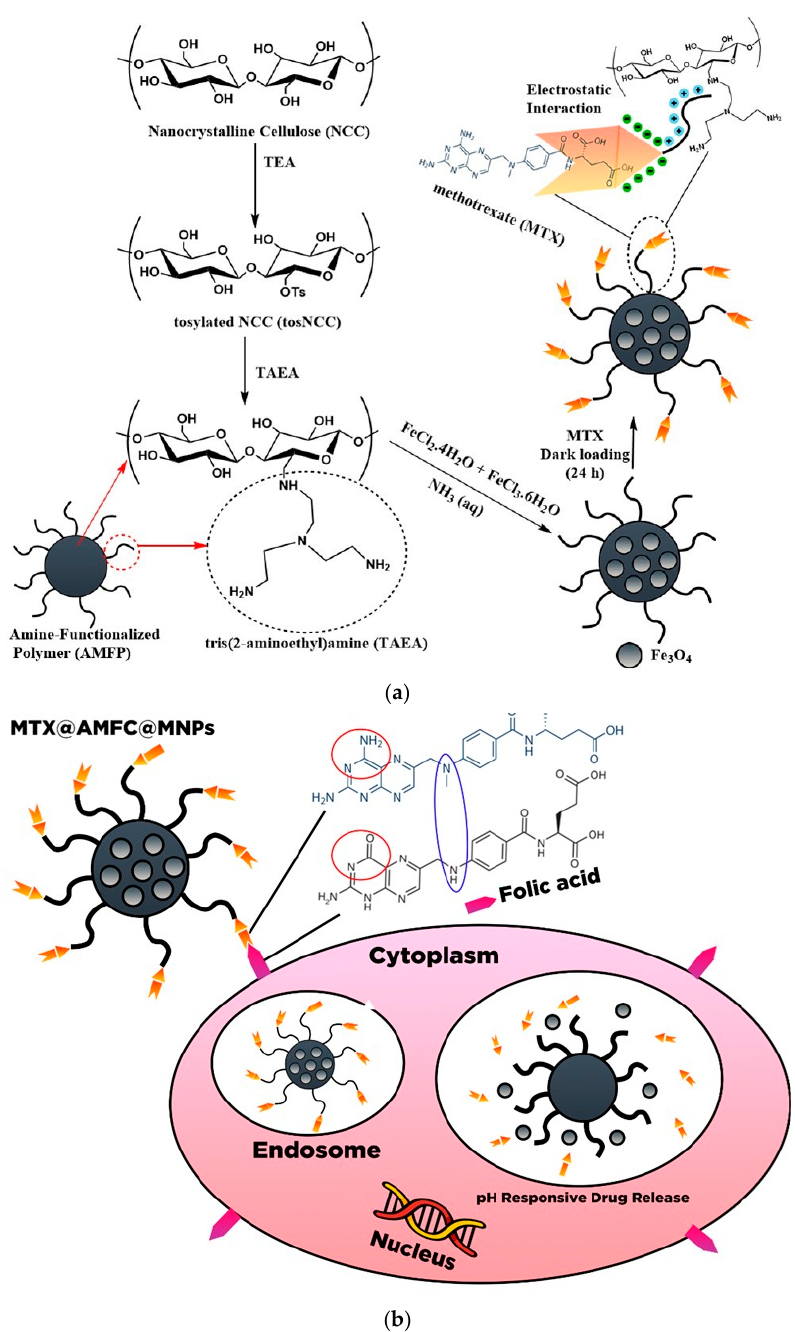
Figure 17. ( a ) Magnetic NCC-based nanocarrier with pH-responsive capability construction. The nanocellulose was undergoing tosylation, which reacted with tosyl chloride for tris(2-aminoethyl)amine (AMFC) functionalization, incorporating amino moieties for electrostatic interaction improvement, which connected into the methotrexate (MTX, anticancer drug) carboxyl groups (MTX@AMFC@MNPs); and ( b ) schematic illustration of pH-responsive and localization of cancer treatment that benefited from the structural similarity between folic acid and MTX, which assists the folate-receptor-mediated cell internalization (this figure is redrawn from [195]. Copyright 1987 Royal Society Of